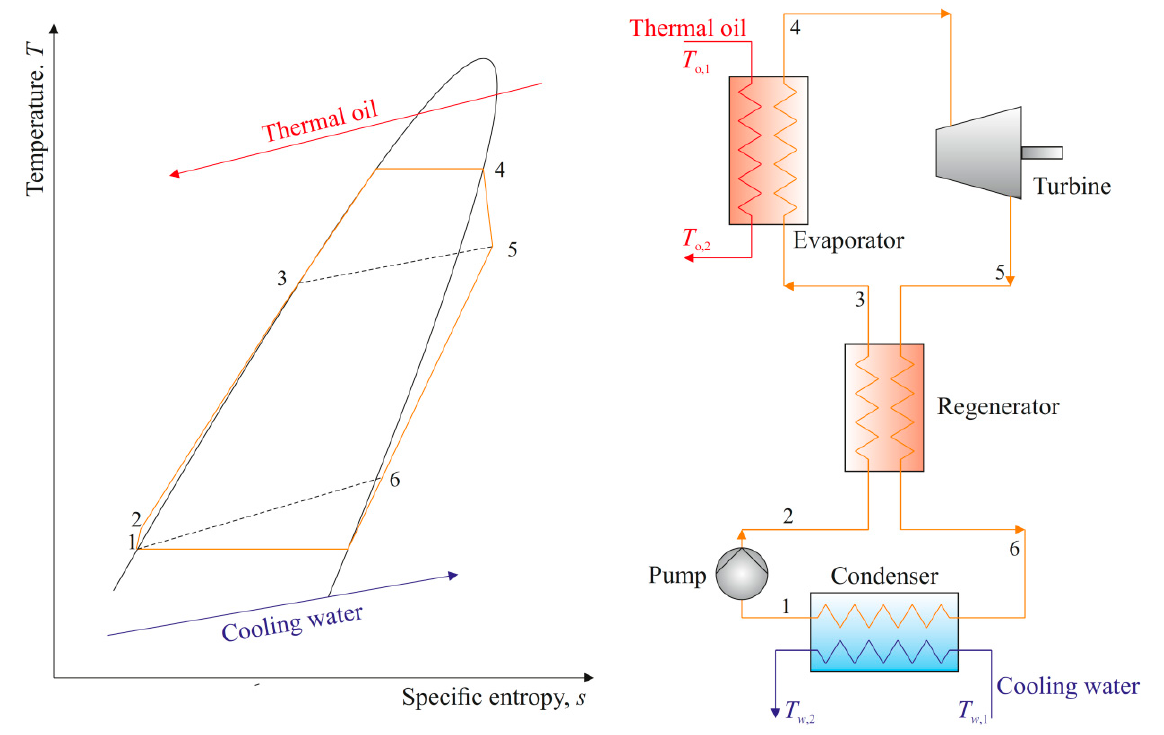
Figure 1. T-s diagram and system layout of the ORC–CHP unit.